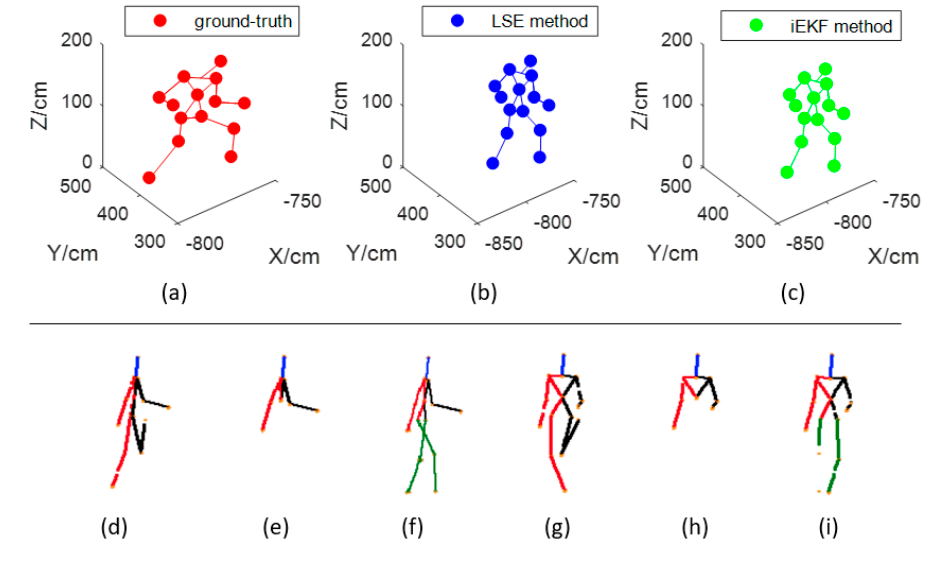
Figure 5. Detecting result for 14 key joints in walking model. ( a ), ( b ) and ( c ) are the first group detected by our designed indoor position system. ( a ) is the original data generated by UE 4.0, ( b ) is the 14 key joints detected by LSE method, and ( c ) is the result detected by iEKF. Figures from ( d ) to ( i ) are the results detected by Kinect sensor. ( d ) and ( g ) are the expected results. ( e ) and ( h ) miss some joints